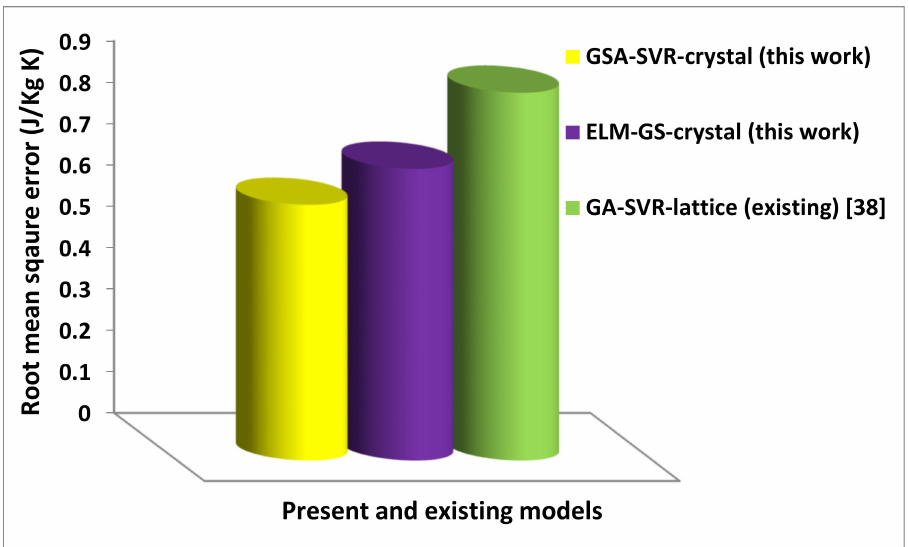
Figure 13. Comparison between the present and existing crystal lattice distortion-based models using the mean absolute error metric.